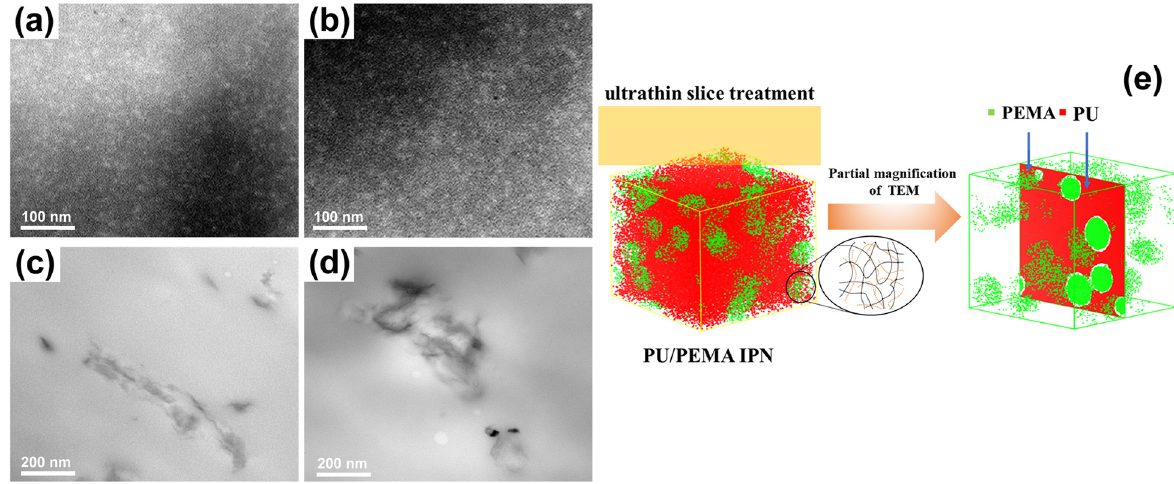
Figure 4: TEM micrographs of ( a and b ) PU/PEMA, ( c and d ) 0.5 wt% GR - PU/PEMA, and ( e ) schematic illustration of the cross - section IPN.